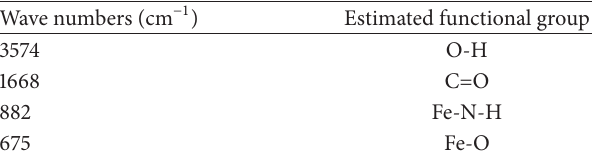
Table 4: Estimated functional groups occurring.